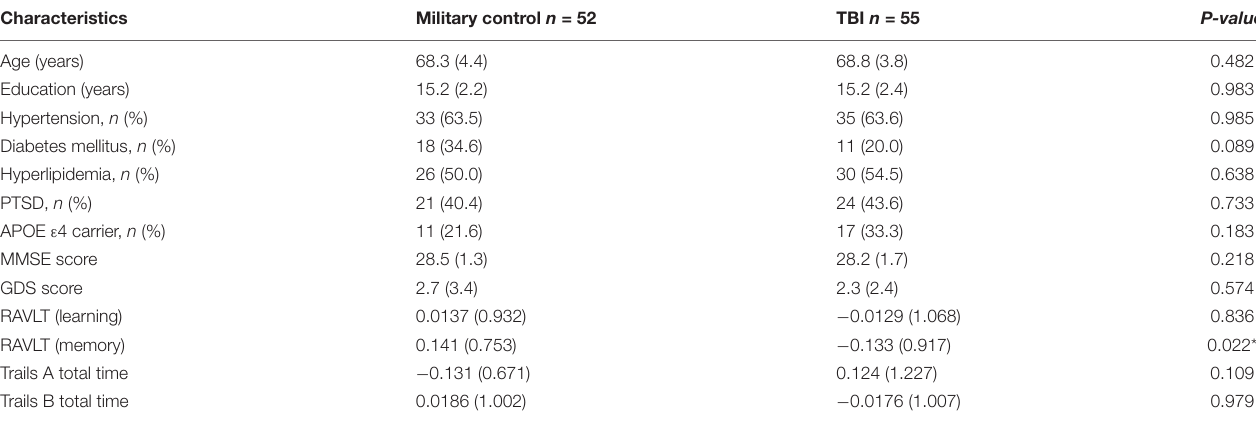
TABLE 1 | Demographics and neuropsychological tests in Vietnam War veterans with and without a history of traumatic brain injury (TBI).